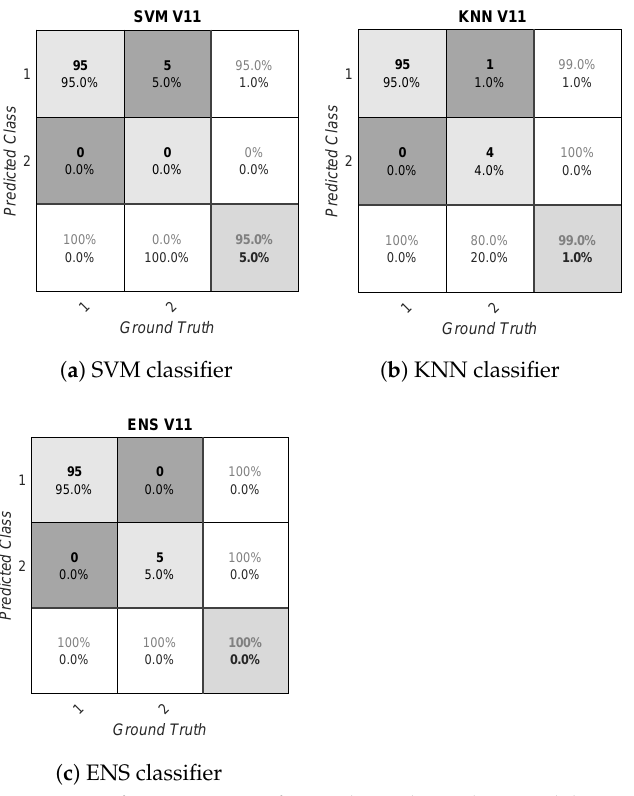
Figure 3. Confusion matrices for a subject-dependent model in V11, detected as a problem in asym- metry.